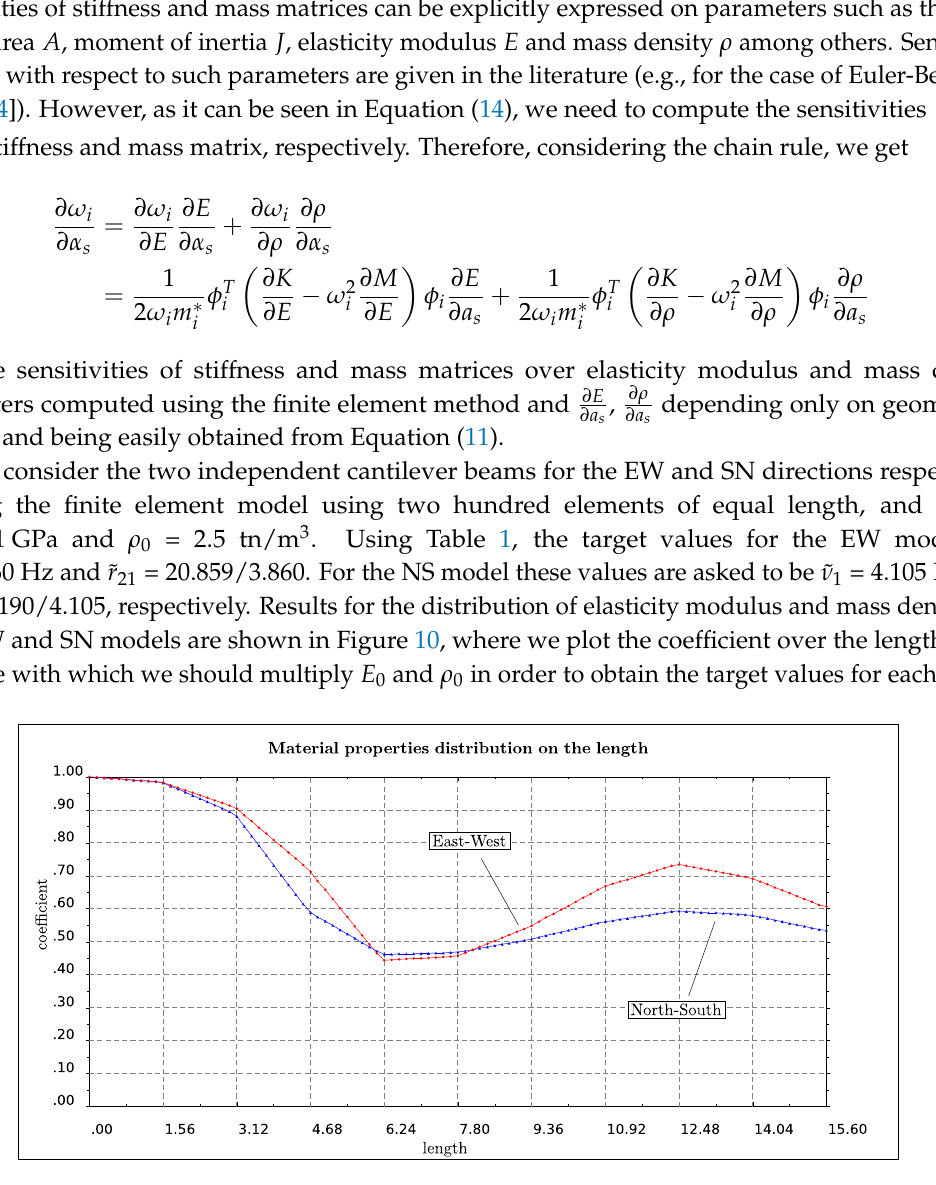
Figure 10. Material properties (elasticity modulus, mass density) nondimensional distribution (vertical axis) with the height (horizontal axis) of the